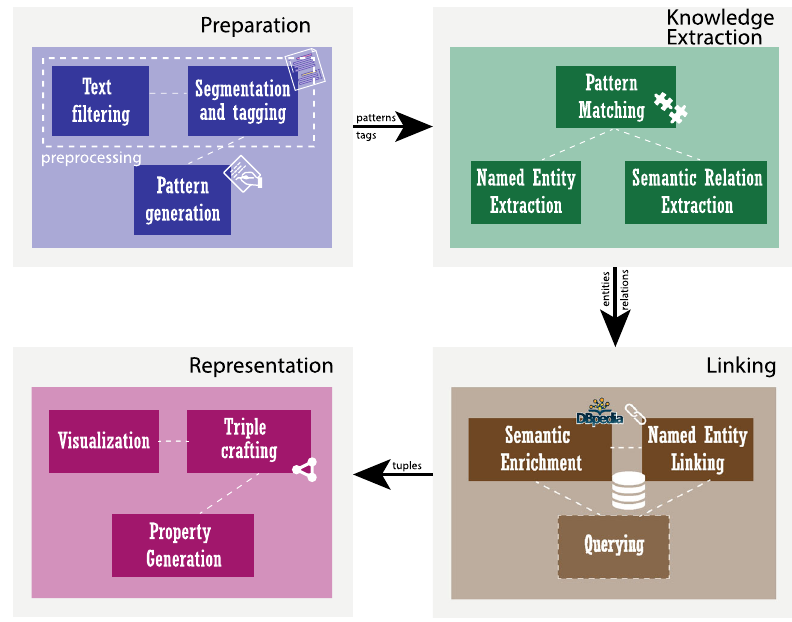
Fig. 1 Proposed method for KG